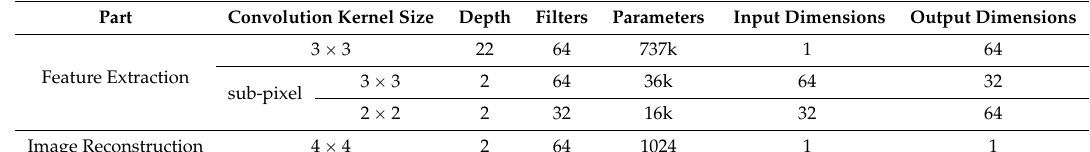
Table 2. Convolution structure of network branches for 4 ˆ SR.